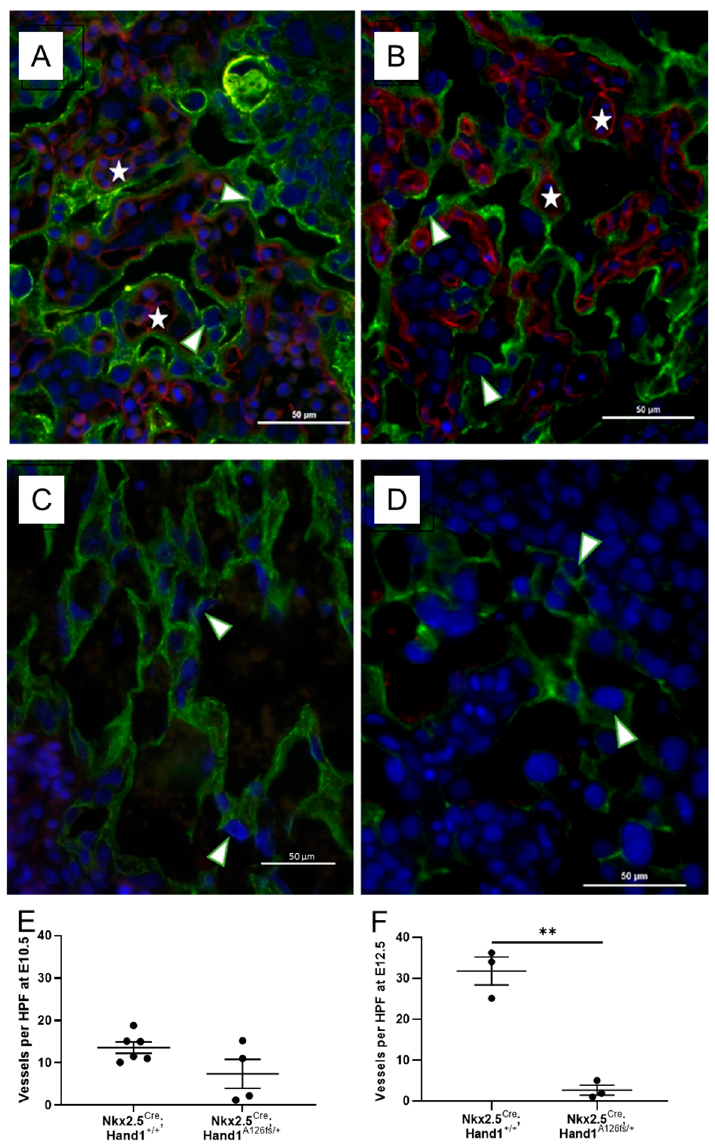
Figure 4. Conditional activation of mutant Hand1 in the placenta results in failed labyrinthine vascular development by embryonic day 12.5 (E12.5). ( A , B ) Control ( Nkx2-5 Cre ;Hand1 +/+ ) placentas exhibited normal development of the fetal vasculature with fetal vessels (Red/Star; CD-31 positive) clearly separated from maternal blood space by trophoblast (Green; Cytokeratin-7 positive) at E10.5 ( A ) and E12.5 ( B ); ( C , D ) Nkx2-5 Cre ;Hand1 A126fs/+ labyrinths however, had very few fetal labyrinthine blood vessels at both E10.5 ( C ) and E12.5 ( D ) and showed disorganization of the trophoblasts with very few remaining cytokeratin-7-positive trophoblasts remaining at E12.5; ( E ) Whilst not statistically significant, fetal vessel counts at E10.5 confirmed a decreased number of fetal vessels ( P = 0.088); ( F ) There was significantly reduced by E12.5 ( P = 0.001). Arrowhead indicates sinusoidal trophoblast giant cells. Nuclei are labelled Blue with DAPI. ( A – D ) are representative images. ( E , F ) individual dots represent average per litter. Data are mean ± SEM. n = 3–6 litters. Statistical significance determined using a students t -test. ** P =